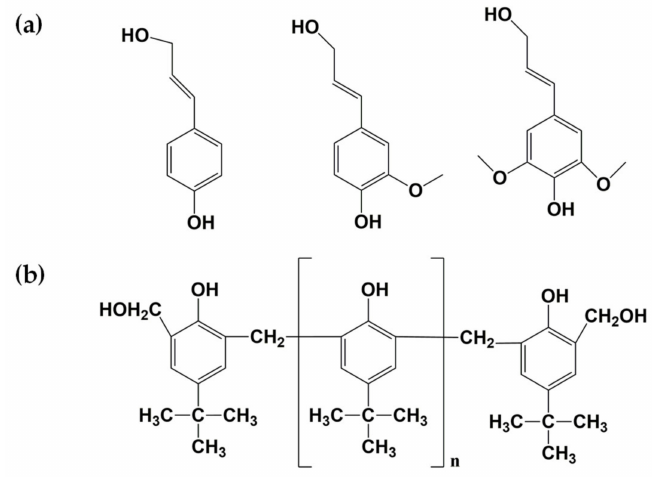
Figure 2. Chemical structure of ( a ) monolignol and ( b ) phenolic